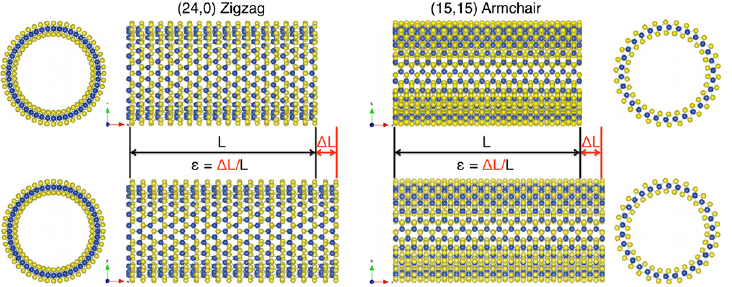
Figure 1. Front and sided views of zigzag and armchair TX and under tensile strain ( ε